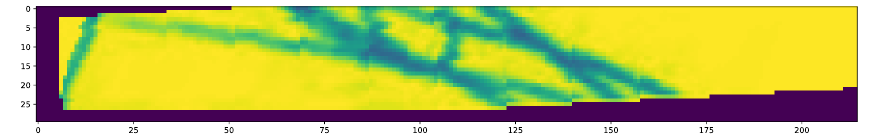
Figure 4. Example of signature modified using data augmentation operations. The yellow area is later filled with the same colour as the background of the signature so as not to introduce noise into the dataset. The image is in its true resolution.